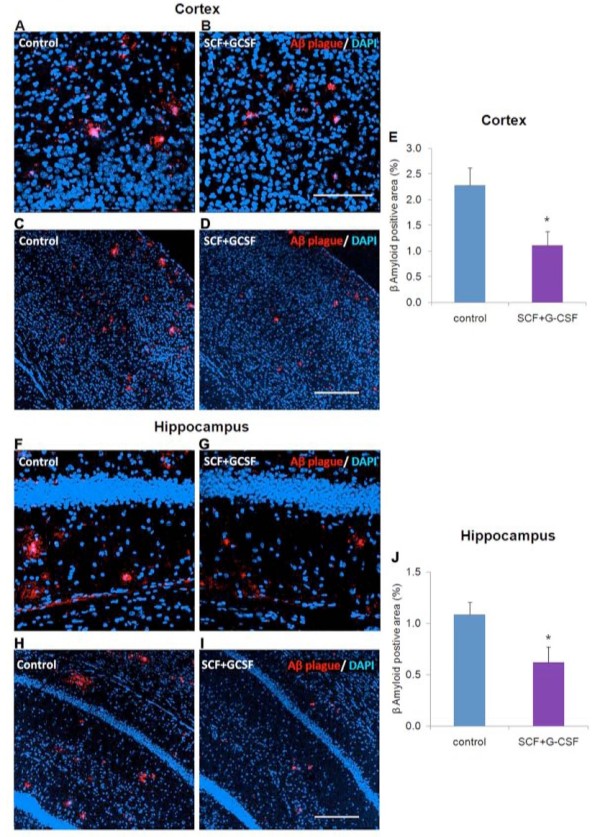
β-amyloid deposits in the brains of APP/PS1 mice. (a), (b) High-power images of β-amyloid (Aβ) deposits in the cortex. β-amyloid deposits are identified with anti-β-amyloid antibody (clone 4G8) (red). (c), (d) Low-power images of β-amyloid deposits in the cortex. Red dots are β-amyloid deposits. (e) Quantification of β-amyloid deposits in the cortex. (f), (g) High-power images of β-amyloid deposits (red) in the hippocampus. (h), (i) Low-power images of β-amyloid deposits (red) in the hippocampus. (j) Quantification of β-amyloid deposits in the hippocampus. Note that β-amyloid burdens both in the cortex and hippocampus are significantly decreased by stem cell factor and granulocyte colony-stimulating factor (SCF+G-CSF). Cell nuclei are stained with 4',6-diamidino-2-phenylindole (DAPI) (blue). Data presented as mean ± standard error. *P < 0.05. Scale bar: (b) 100 μm (for images in (a), (b), (f) and (g)); (d), (i) 200 μm (for images in (c), (d), (h) and (i)).